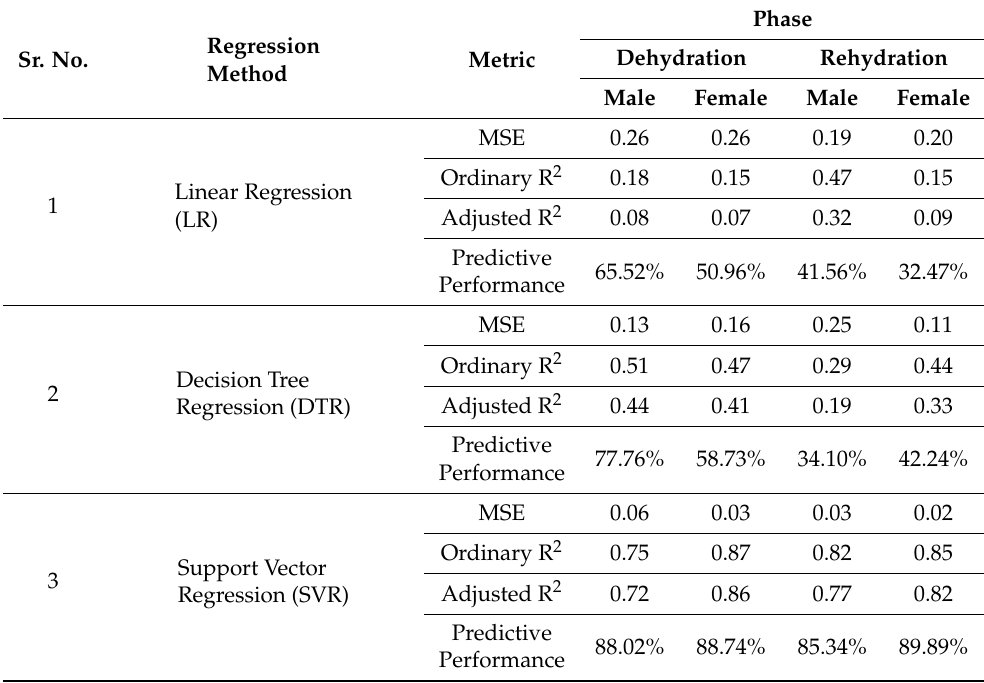
Table 8. Results for sex-specific analysis—Case 1: using the models originally trained on the entire data (both male and female participants).